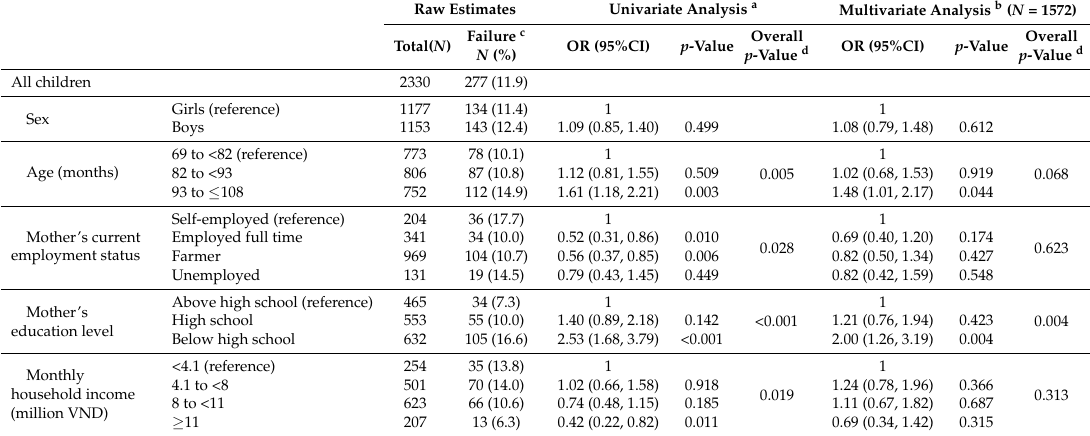
Table 5. Prevalence of anthropometric failure and associated sociodemographic factors in 6–9-year-old children in rural areas of Vietnam.